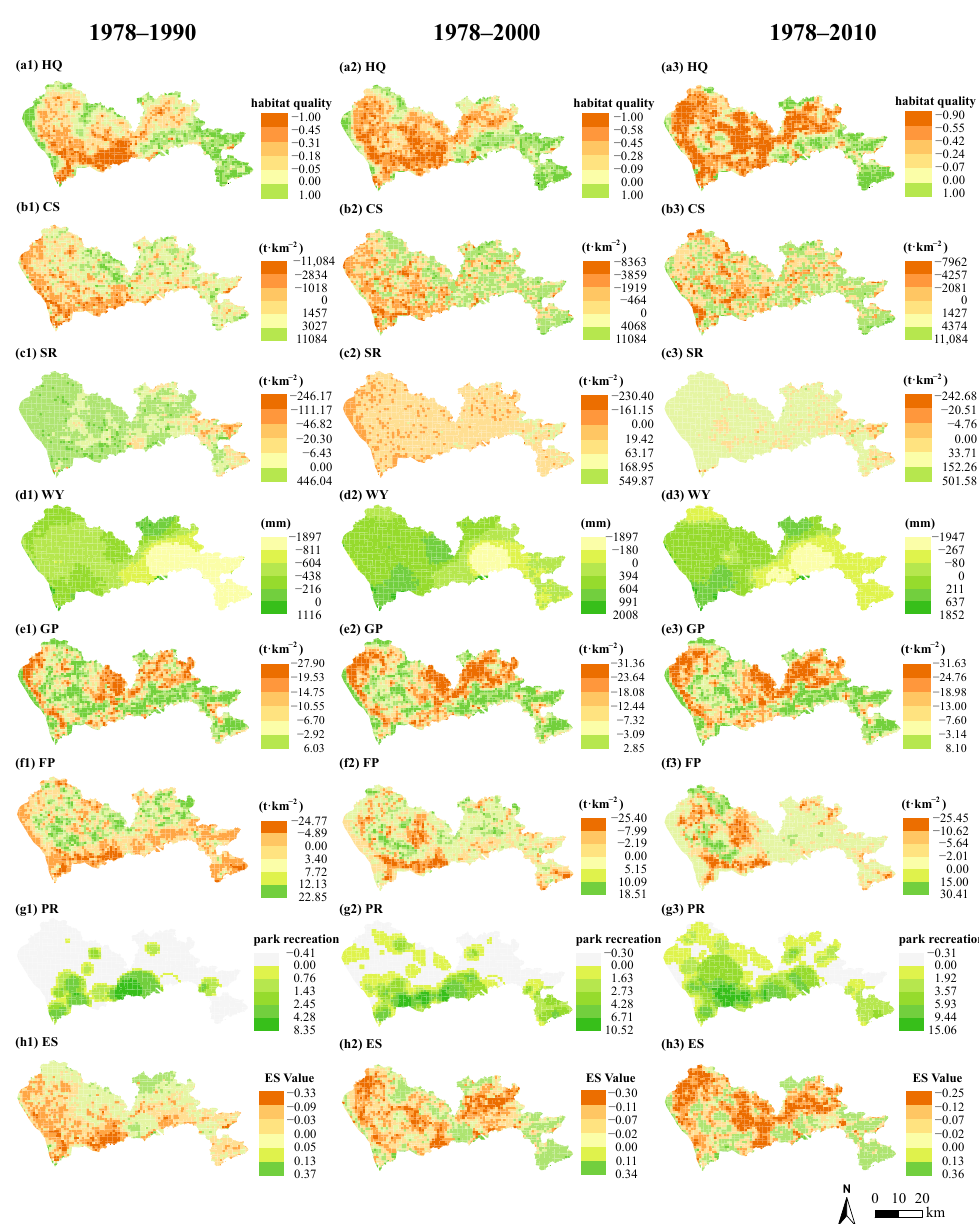
Figure A1. Spatial pattern of changes in ecosystem services in Shenzhen at different time periods: ( a1 – h1 ) 1978–1990 changes; ( a2 – h2 ) 1978–2000 changes; ( a3 – h3 ) 1978–2010 changes.